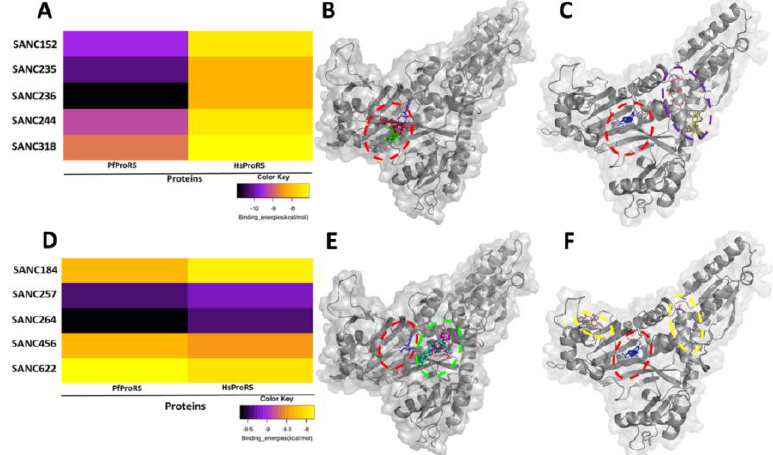
Figure 2. Binding energy (kcal/mol) heat maps and binding modes of the selected orthosteric and allosteric hit compounds on PfProRS and HsProRS. ( A ) Binding energies of orthosteric hit compounds. Selected orthosteric hits binding at the PfProRS active site are shown at the left side of the heat map. Binding energy increases from black to yellow. A black colour shows good binding energy. ( B ) Binding modes of identified orthosteric hit compounds on PfProRS. ( C ) The binding modes of the selected orthosteric hits in HsProRS. In HsProRS, selected orthosteric ligands do not bind the targeted active and allosteric sites. ( D ) Binding energies of allosteric hit compounds. Selected allosteric hits binding at the PfProRS allosteric site are shown at the left side of the heatmap. A black colour shows good binding energy. ( E ) Binding modes of identified allosteric hit compounds on PfProRS. ( F ) Binding poses of identified allosteric hits in HsProRS. Selected allosteric hits do not bind the targeted active and predicted allosteric site in HsProRS. Adenosine binding pose at the active site is shown in blue sticks. The active site is shown in red ellipse while the identified allosteric site is shown in green ellipse. Binding modes of identified orthosteric and allosteric hits on HsProRS are shown in purple and yellow ellipses, respectively. Int. J. Mol. Sci. 2020 , 21 , x FOR PEER REVIEW